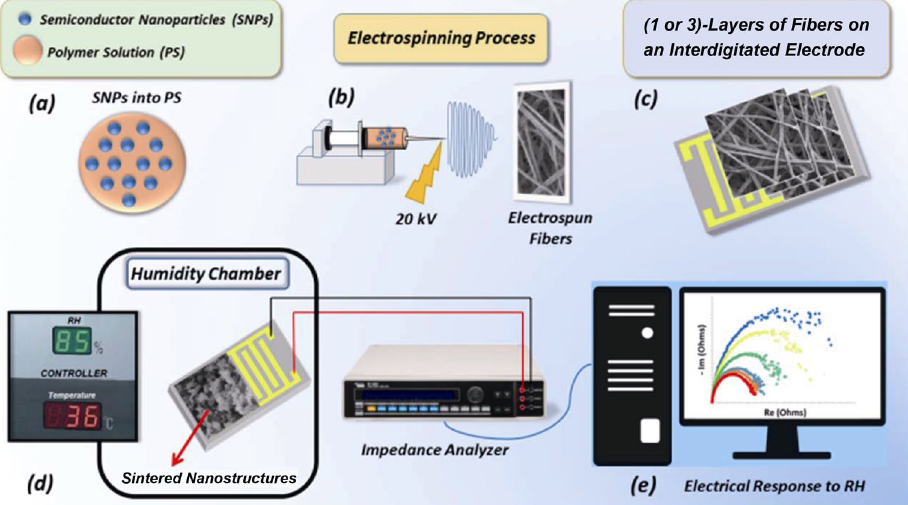
Fig. 1 Scheme of the structure preparation and electrical characterization: (a) semiconductors into polymeric solution for the electrospinning process, shown in (b); (c) fiber layers arranged on a gold interdigitated electrode; (d) sintered TiO 2 /WO 3 structures in a humidity chamber; (e) analysis of the electrical response to